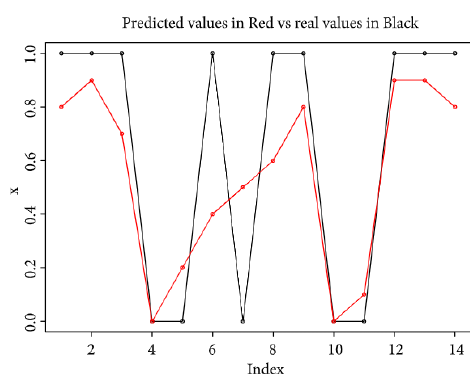
Figure 3 : Predicted values versus real values (predicted values in red, real values in black); for Probit